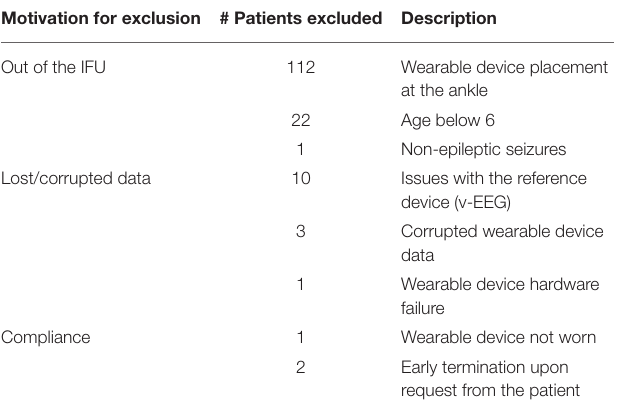
TABLE 2 | Distribution of patients, wearable device type and CS events across the different clinical